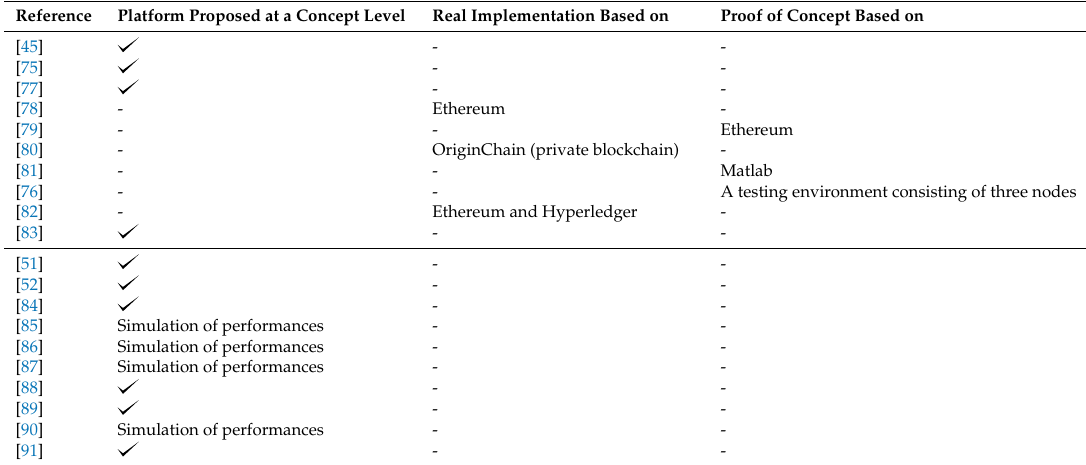
Table 11. Level of implementation of papers belonging to C 1 and C 2